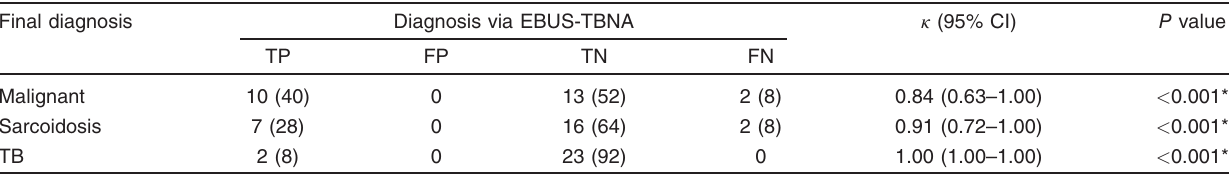
Table 8 Comparison of endobronchial ultrasound-guided transbronchial needle aspiration results with final diagnosis Final